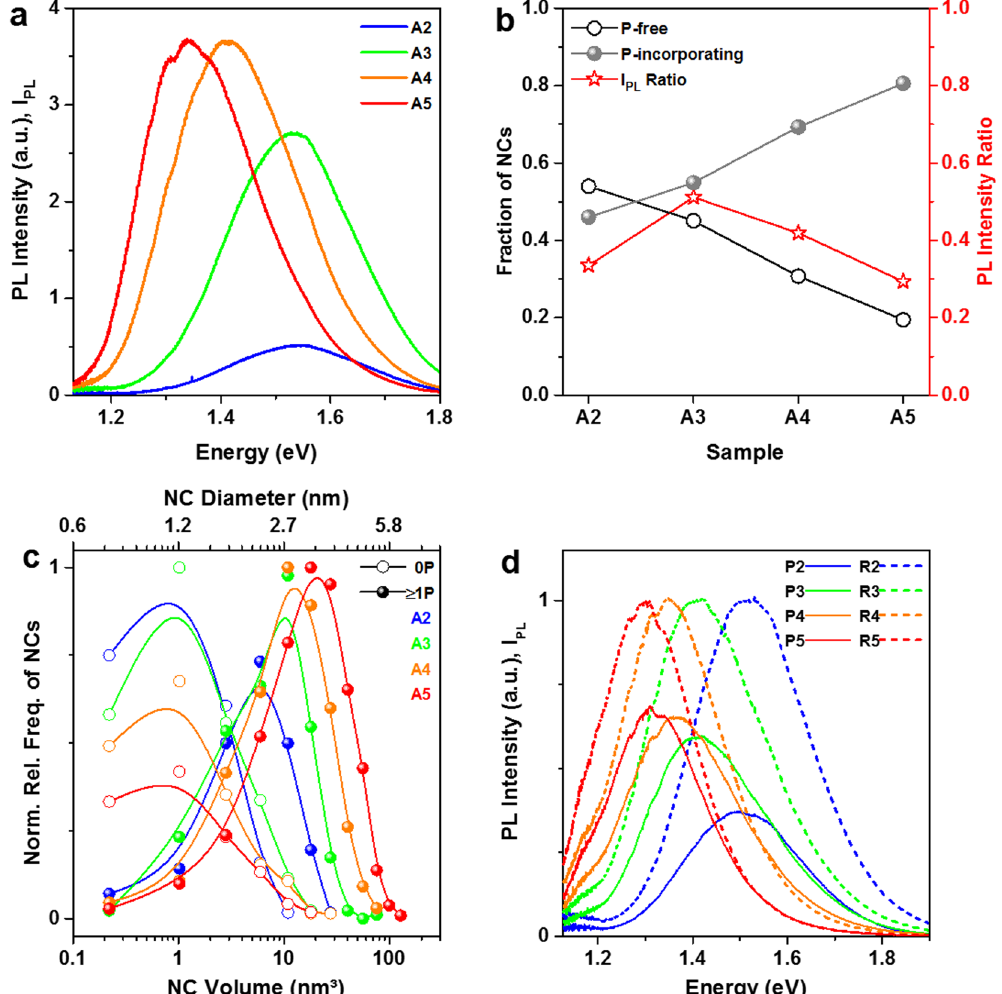
Figure 2. Photoluminescence analysis. ( a ) PL spectra of all A-samples (H 2 -passivated). Despite substantial P-concentrations NC-size dependent PL spectra are measured. ( b ) Comparison of the fraction of P-incorporating and P-free NCs with the integrated PL intensity ratios (P-doped divided by undoped references) of sample set A. Except for A2, the PL intensity seems to scale with the amount of undoped NCs in each sample. ( c ) Size distribution of the P-free (open symbols) and P-incorporating (filled symbols) subsets of the NC ensemble. The P-free NCs in each sample have a mean diameter of ~1.3 nm, while the size distribution of the P-incorporating NCs follows the trend of SRON:P thickness. ( d ) PL spectra of all H 2 -passivated samples of set E. Each spectrum of the undoped reference samples (dashed lines) is normalized to 1 and the respective P-doped sample (solid lines) is scaled by the same factor. The P-doped SiO 2 reference without Si NCs (sample SiO 2 :P) does not emit any measurable PL and is therefore omitted